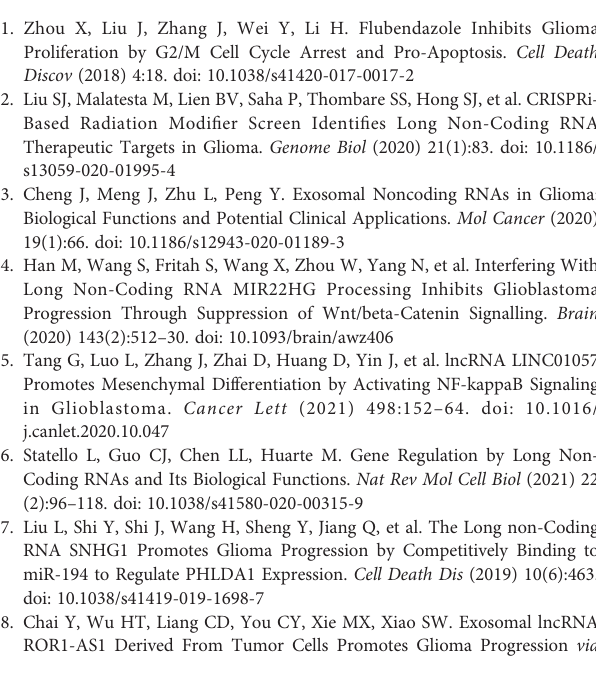
Supplementary Figure 2 | Upregulation of HOXC-AS3 promotes proliferation, migration, and invasion of glioma in vitro . (A, B) qRT-PCR was used to detect the expression of HOXC-AS3 in U87 and U251 cells transfected withNC orHOXC-AS3 plasmid. (C, D) CCK-8 assay was used to detect the proliferation of U87 and U251 cells transfected with NC or HOXC-AS3 plasmid. (E – H) EdU assay was used to detect the proliferation of U87 and U251 cells transfected with NC or HOXC-AS3 plasmid. (I, J) Transwell assay was used to detect the migration of U87 and U251 cells transfected with NC or HOXC-AS3 plasmid. (K, L) Transwell assay was used to detect the invasion of U87 and U251 cells transfected with NC or HOXC-AS3 plasmid. T-test for (A, B, F, H, J, L) . Two-way ANOVA and post hoc test for (C, D) . *P < 0.05, **P < 0.01. Supplementary Figure 3 | The expression of 24 genes downstream of miR-216 was predicted by GEPIA. Supplementary Figure 4 | Quanti fi cation and statistical analysis of the tumors in xenograft mouse model. T-test was used. *P < 0.05, **P < 0.01. Supplementary Figure 5 | Median survival analysis of xenograft mouse model. Log-rank test was used. *P < 0.05, **P < 0.01. Supplementary Figure 6 | Statistical analysis of the three random fi elds of the expression level of Ki-67 and TUNEL staining. T-test was used. *P < 0.05, **P <